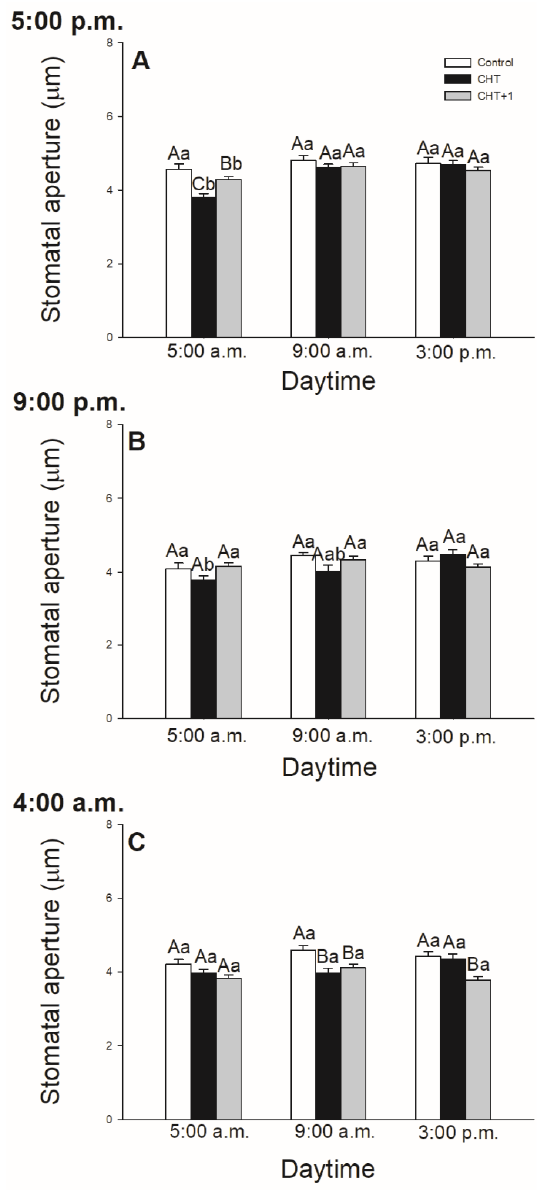
Figure 1. Changes in the size of stomatal apertures on the abaxial epidermal strips of intact tomato plants treated foliar with 100 μg mL -1 chitosan (CHT) dissolved in the experimental buffer (1 mM AA, 10 mM MES/TRIS, 10 mM KCl, 0.1 mM CaCl 2 , pH 6.15) at different daytimes: at the end of light cycle (17:00 hrs) ( A )), at night (21:00 hrs; ( B )), and at dawn (04:00 hrs; ( C )). Measurements were disposed at constant times after treatments (17:00, 09:00, and 15:00 hrs). Means ± SE, n = 3. Means were analyzed